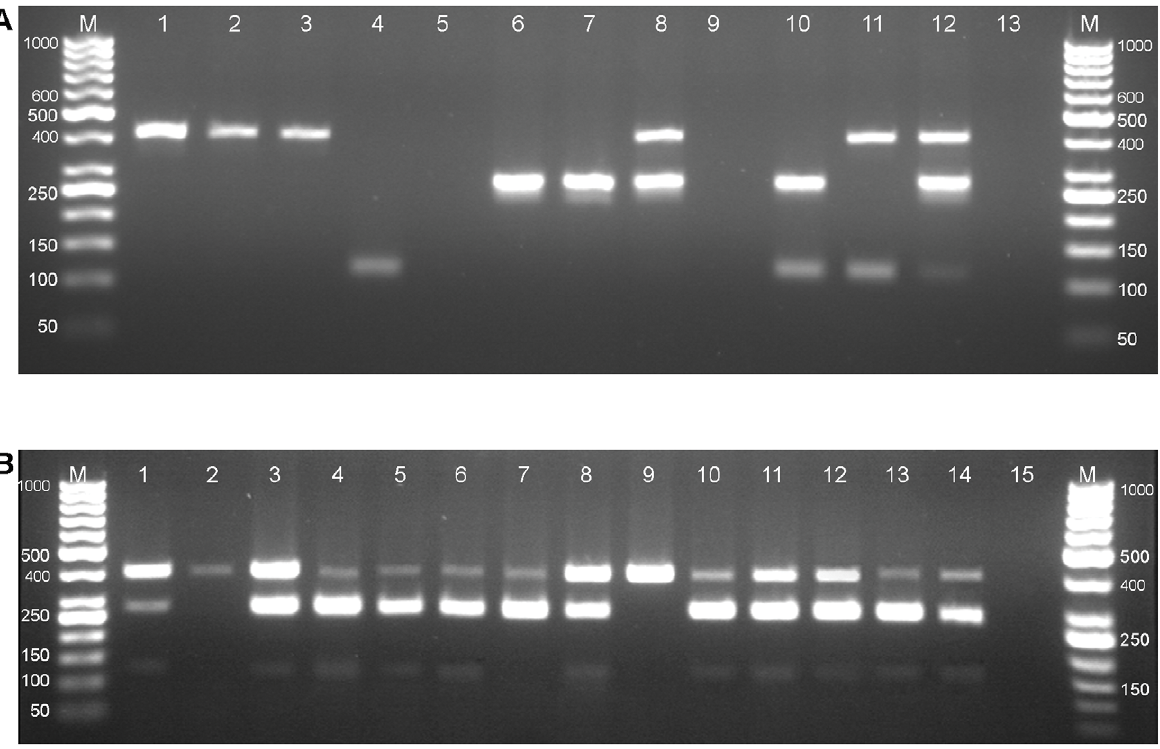
Figure 4. Multiplex PCR amplification of DNA extracted from fecal samples. A. of dogs: Lane M; 50 bp ladder, Lane 1, positive control; Lane 2–11 samples; Lane 13, negative control. B. of wild carnivores: Lane M, 50 bp ladder, lane 1–2 and 6–12, jackal samples; Lane 3–5, fox samples; Lane 13, wolf sample; Lane 14, hyena sample; Lane 15, negative control.